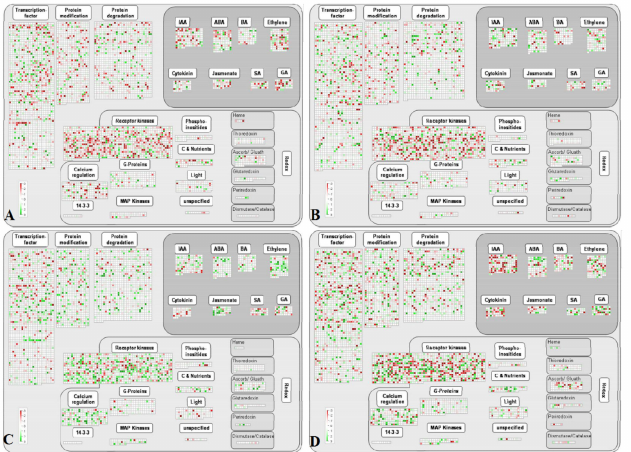
Figure 5. DEGs assigned to the overview of regulatory pathways in different comparison groups based on MapMan. The overview mainly consists of transcription factors, protein modifications, protein degradation, hormone synthesis and signal transduction, redox reactions, receptor kinases, phosphoinositides, C&Nutrients, light, G-proteins, MAP kinases, calcium regulation, and the unspec- ified part. The relative transcription levels of genes related to each part are displayed in the heatmap. Green represents upregulation, while red represents downregulation. ( A , B , C , and D ) represent the comparison group of XFSUV vs. XFSCK, XFLUV vs. XFLCK, ZCSUV vs. ZCSCK, and ZCLUV vs. ZCLCK,